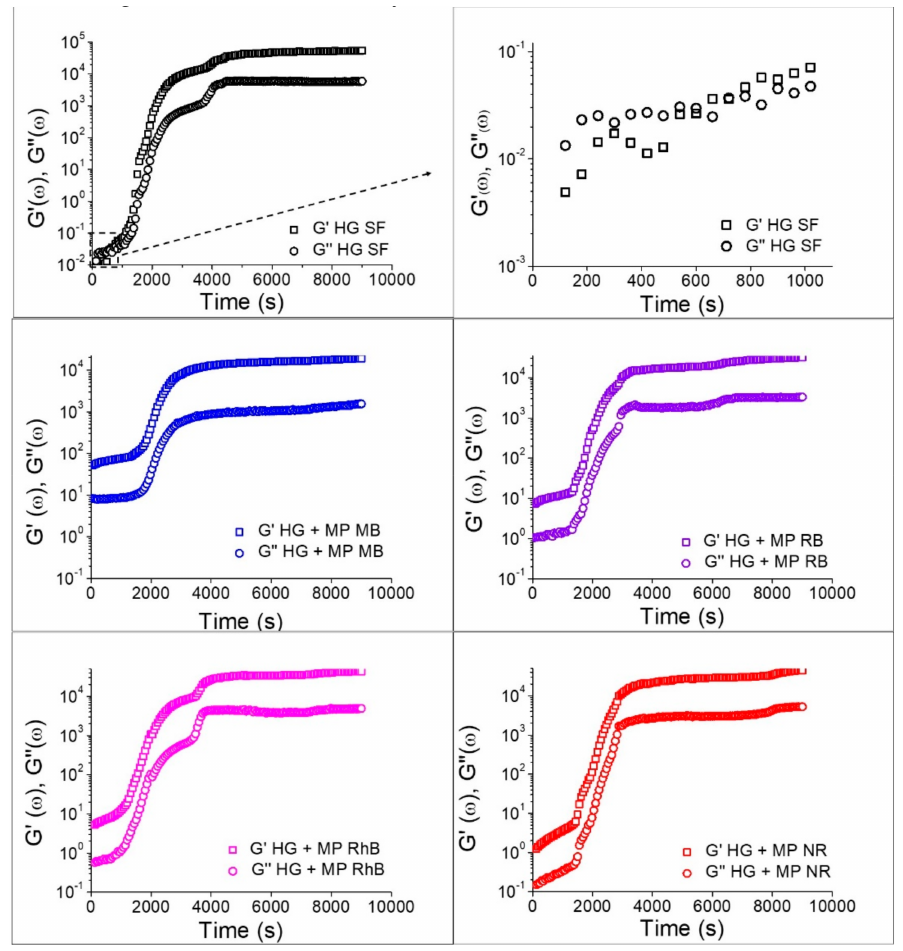
Figure 5. Storage modulus (G (cid:48) ) and Loss modulus (G”) as a function of time of the SF hydrogel and SF hydrogels containing the microparticles loaded with